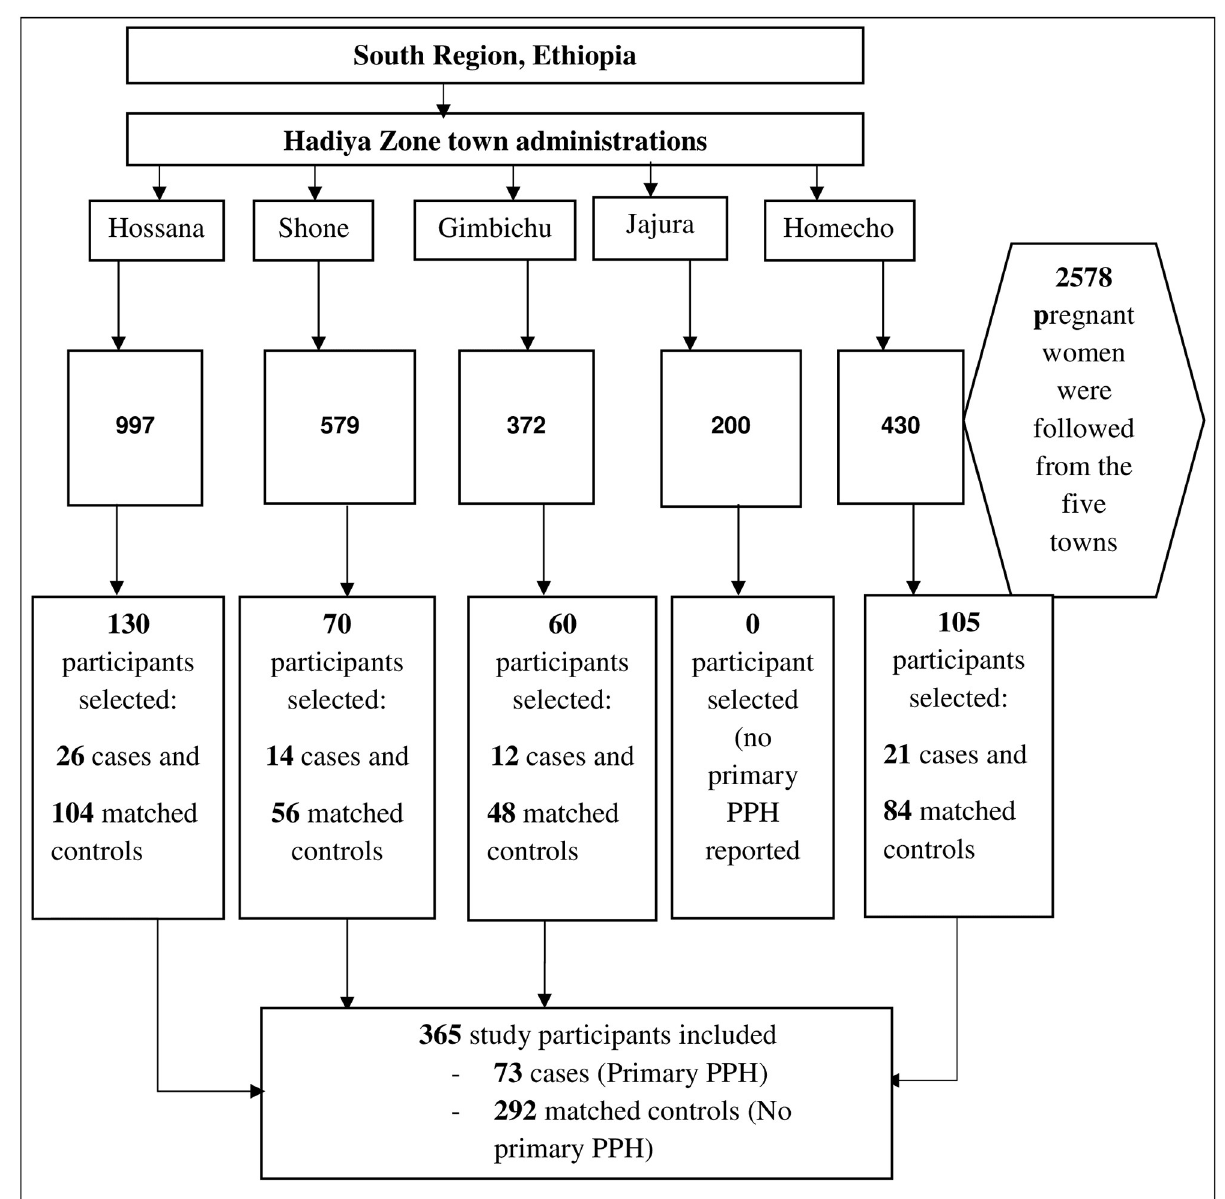
Fig 1. Schematic presentation of sampling procedure for the study of primary PPH in the urban South Ethiopia, July 2019-September 2020.